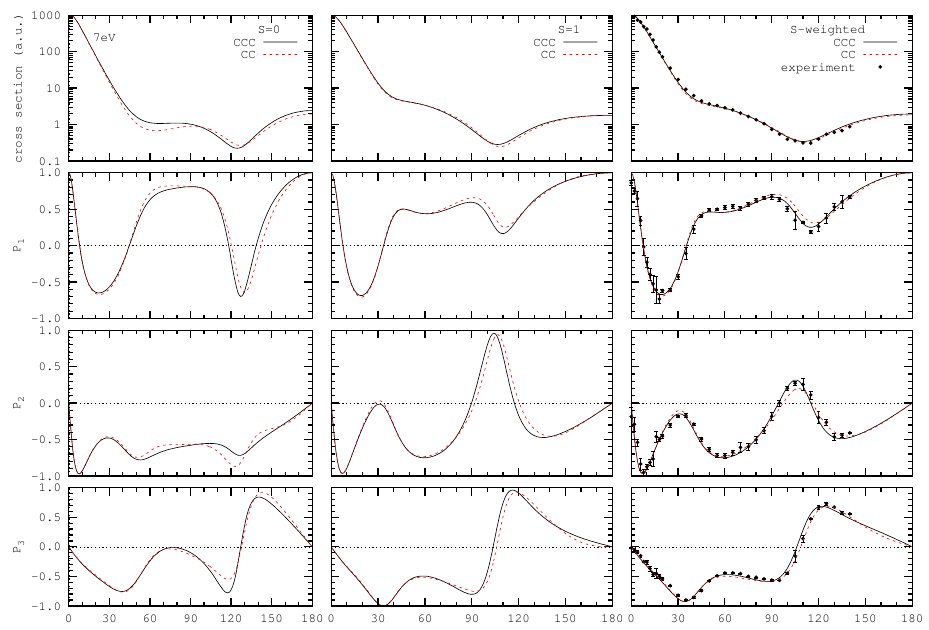
Figure 1. Differential cross section and (reduced) Stokes parameters for 7 eV electron-lithium 2P excitation. CCC results are convergent in the treatment of the Li discrete and continuous spectrum, whereas CC results are convergent in the treatment of the discrete spectrum only. Experiment is due to Karaganov et al.